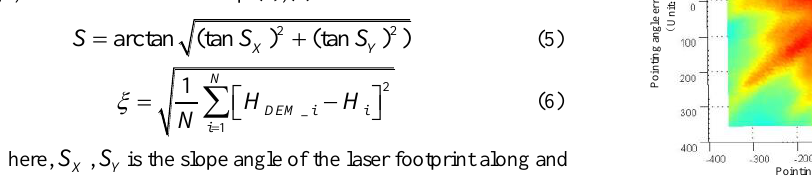
Figure 3. Elevation error distribution of laser foot prints with different pointing error viewing from the